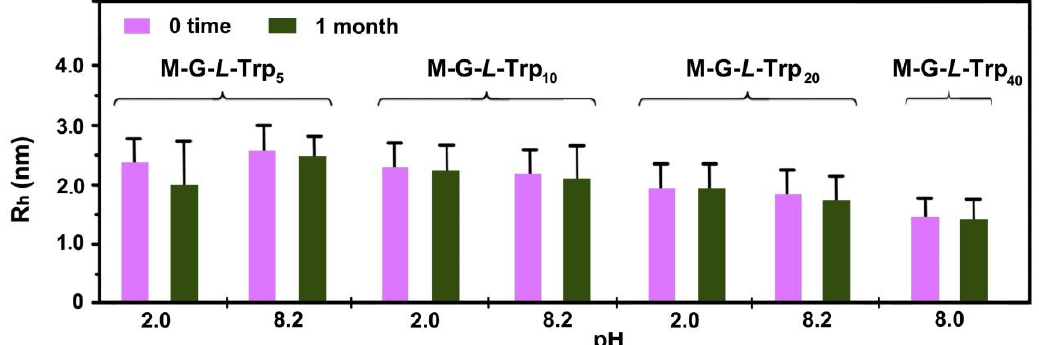
Figure 5. Hydrodynamic radius of M-G- L -Trp copolymers at 0 and 1 month. Data were recorded in 0.1 M NaCl at 1 mg·mL − 1 and 25 °C.